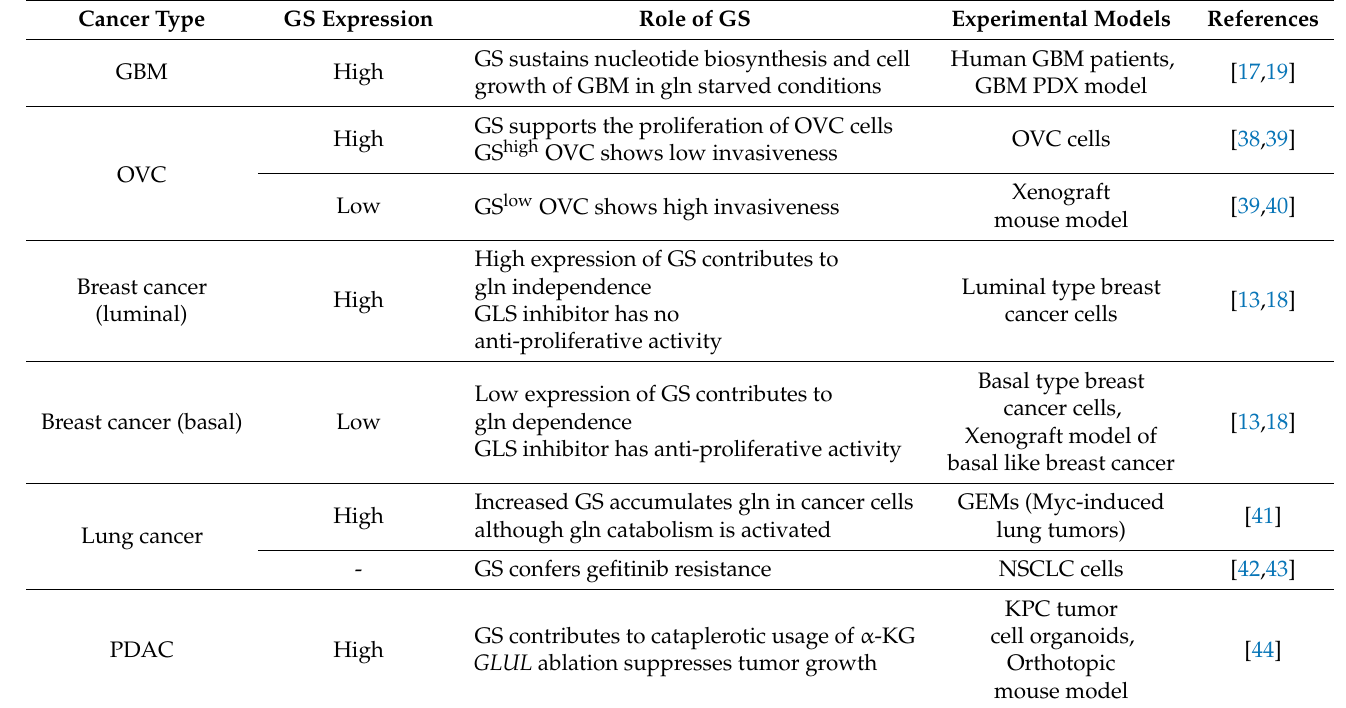
Table 1. Diverse roles of GS in different cancer